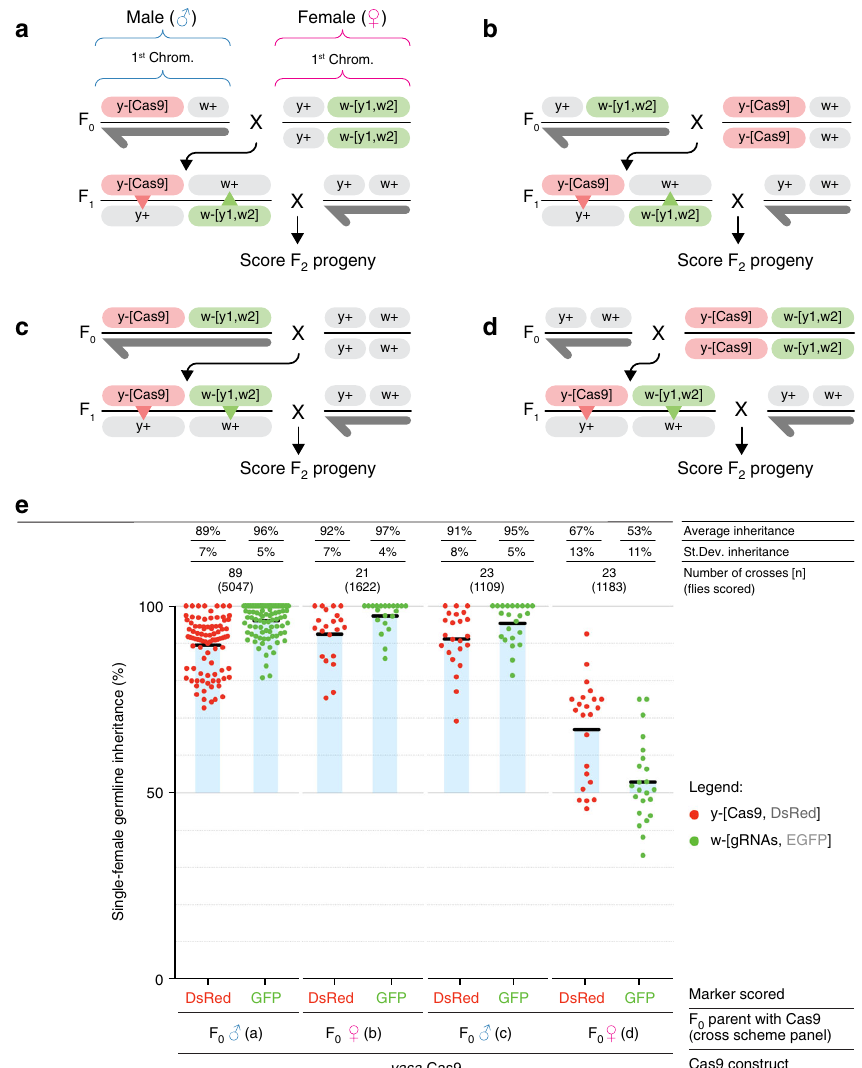
Fig. 2 tGD targeting the yellow and white loci uncovers the maternal effect mechanism. a – d Genetic crosses performed using the tGD elements targeting yellow (DsRed-Cas9) and white (GFP- y1 , w2 -gRNAs) loci, both located on the fi rst chromosome (X chromosome). Cross schemes used to test the F 1 female germline by scoring the F 2 progeny: a Cas9 from the F 0 male and gRNAs from the F 0 female, b Cas9 from the F 0 female and gRNAs from the F 0 male, c both Cas9 and gRNAs from the F 0 male, and d both Cas9 and gRNAs from the F 0 female. Allelic conversion events are indicated by the red and green triangles in the F 1 females of every cross scheme. e Analysis of the F 2 inheritance rates of the fl uorescent markers for all cross scheme combinations ( a – d ) using Cas9 constructs driven by the vasa promoter. Strong super-Mendelian inheritance is seen for all conditions except when both Cas9 and the gRNAs are inherited from the F 0 female ( d ). Values for the inheritance average (black bar), standard deviation, number of samples ( n ), and total number of fl ies scored in each experiment are represented over the graph in line with the respective data. Sex of the F 0 parent carrying Cas9 is indicated with “ ♂ ” for males and “ ♀ ” for females in panel ( e ). Raw phenotypic scoring is provided as “ Supplementary Data 2 ”